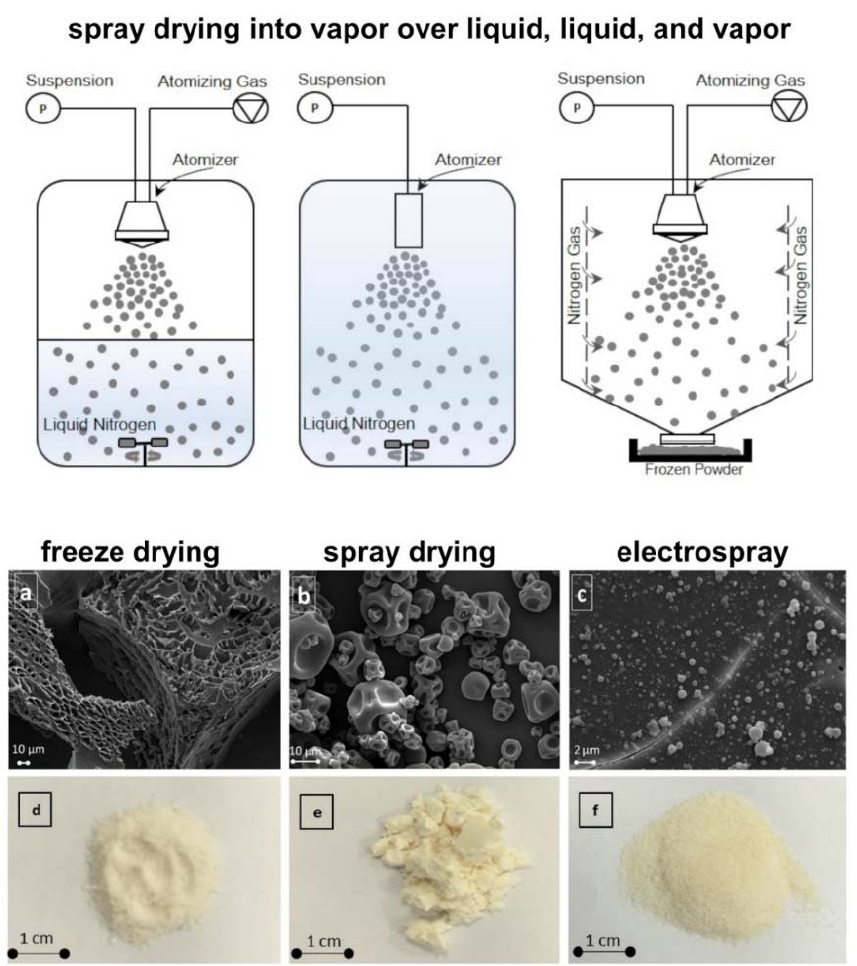
Figure 4. The schematic illustration of spray-drying protocols in vapor over liquid, liquid, and vapor phases(upper, adapted from Adali et al. [114], based on the CC BY 4.0 License), and the comparison of phages lyophilized via freeze-drying ( a , d ), spray-drying ( b , e ), and electrospray ( c , f ). Both SEM images and phage powder form show significant differences in phage formulations (adapted from Ergin et al. [115], based on Elsevier License No. 5375361146341).